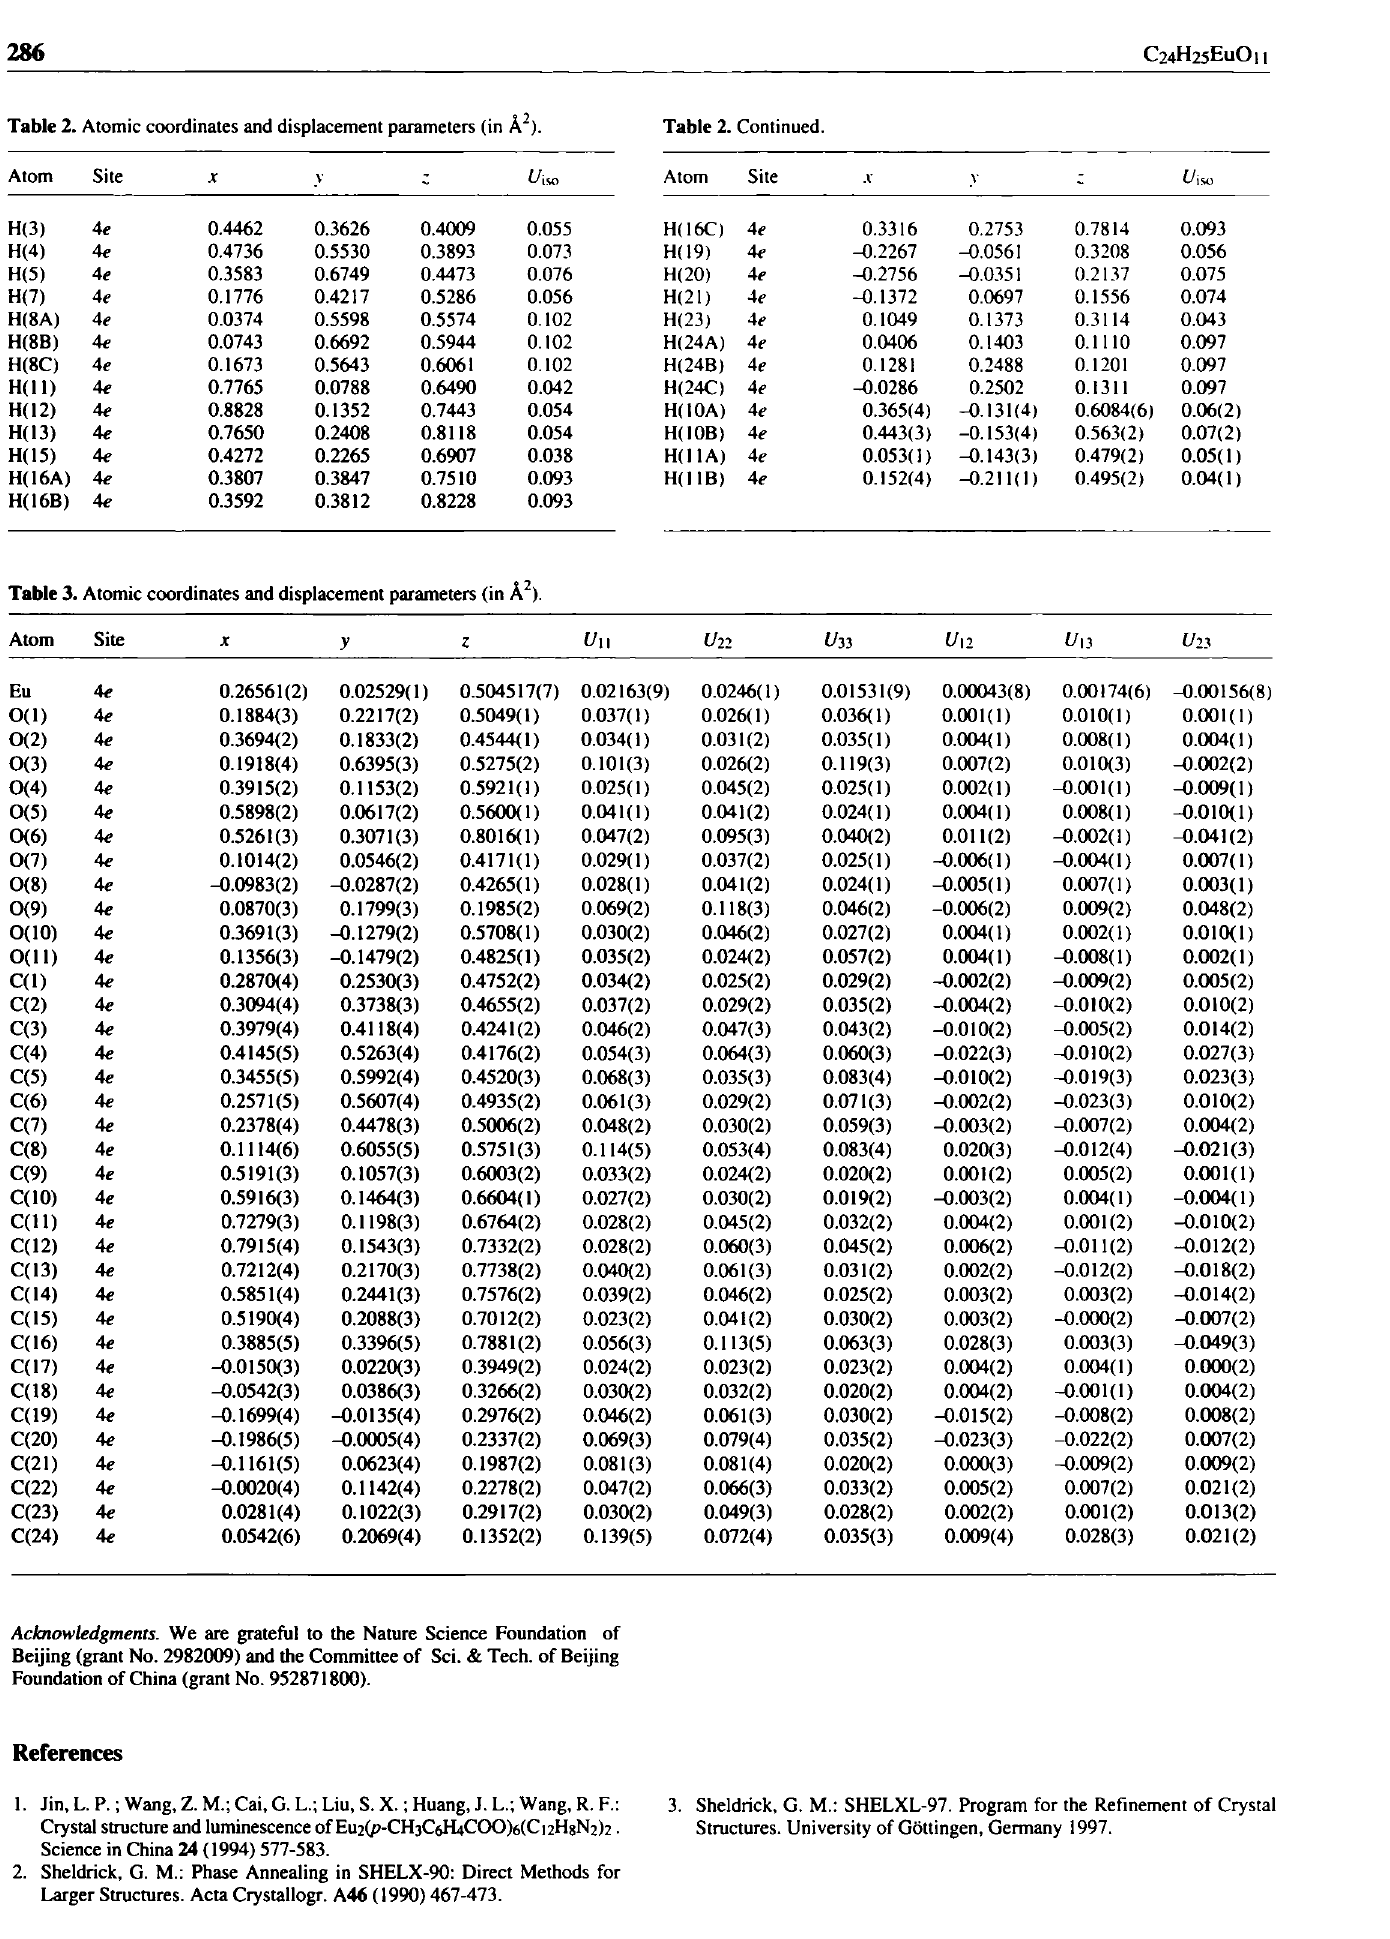
Table 2. Atomic coordinates and displacement parameters (in Ä 2 ).